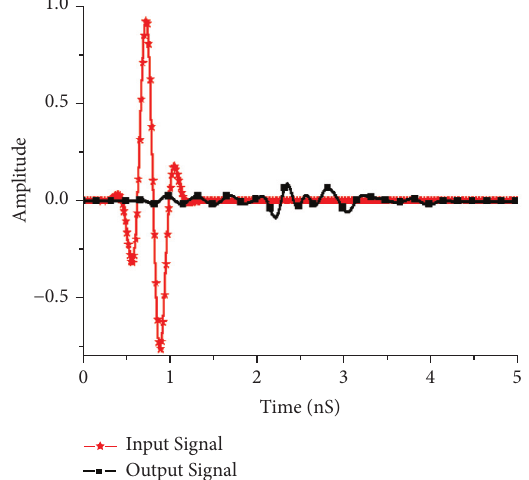
Figure 7: Time-domain performance of the proposed antenna.